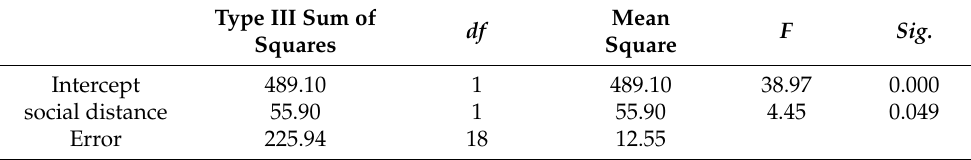
Table 15. Tests of Between-Subjects Effects of P2 amplitude (prevention